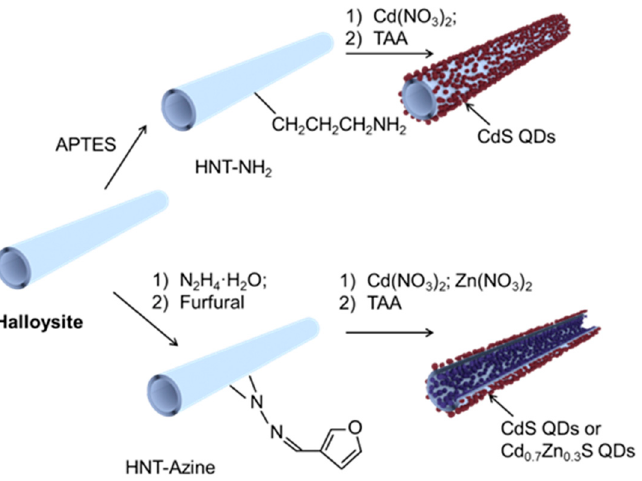
Figure 1. Scheme synthesis of CdS/HNT-Azine, Cd 0.7 Zn 0.3 S/HNT-Azine and CdS/HNT-NH 2 .